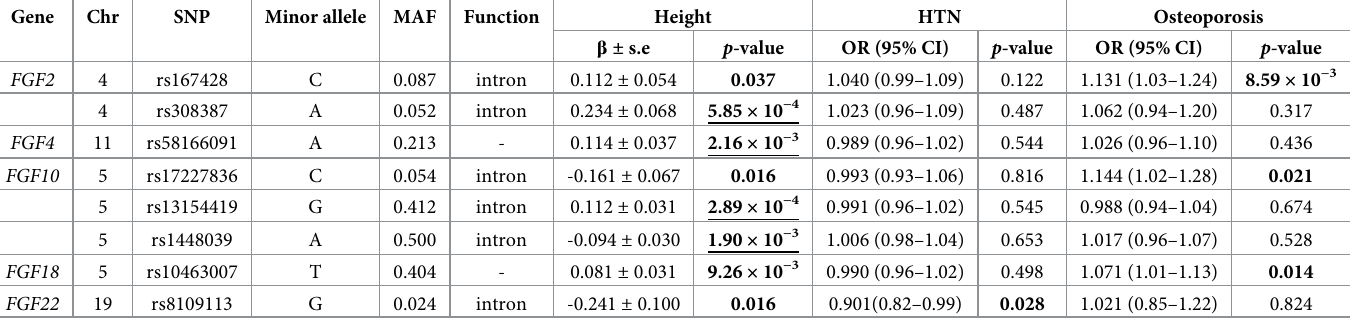
Table 2. Genetic variants in the FGF family associated with two of the three phenotypic traits (height, hypertension, and osteoporosis) or below the Bonferroni-cor- rected significance